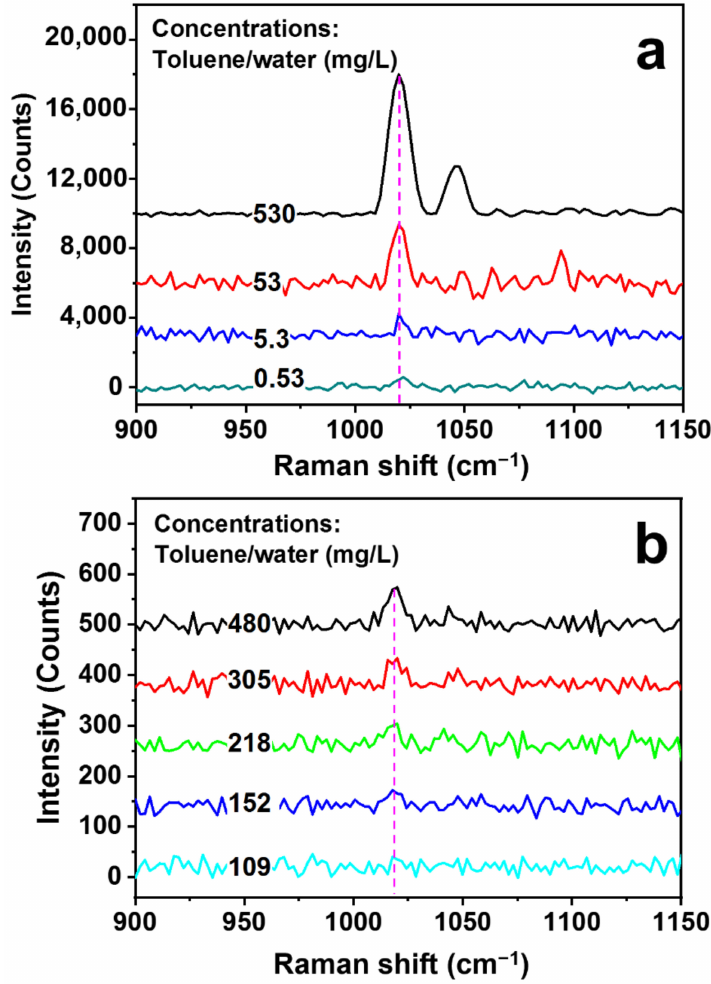
Figure 4. ( a ) Measurements of Raman spectra on the toluene/water solutions with concentrations of 530, 53, 5.3, and 0.53 mg/L using SERS hollow fibers. ( b ) Direct Raman measurement results of toluene/water solutions with different concentrations using a conventional scheme without SERS hollow